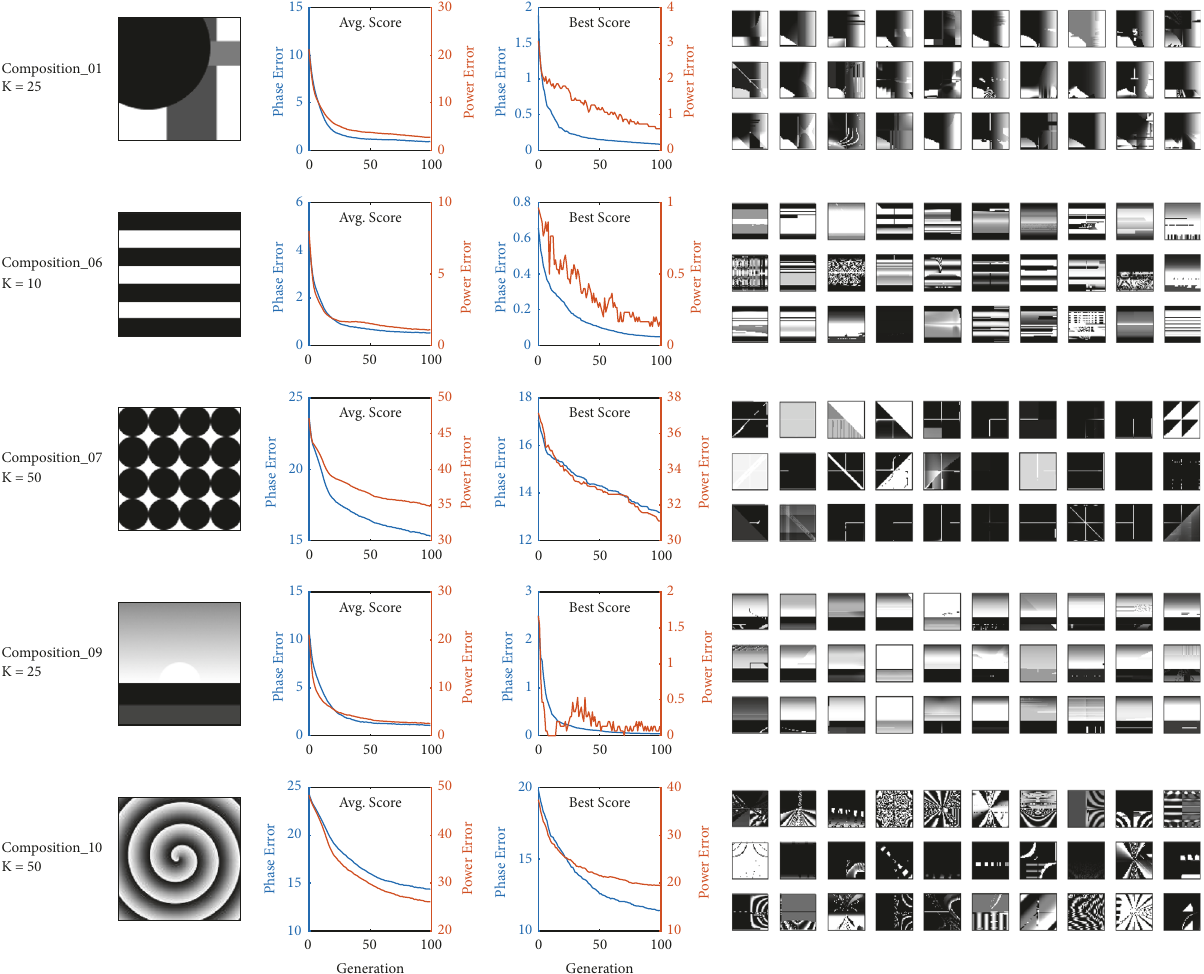
Figure 7: Compositional summary charts and examples. Each row of the figure captures the summary for a target over 30 runs. Leading with the target image, the next two columns show performance plots of the fitness measure (average over 30 runs). The leftmost plot displays the performance through the population average,where the rightmost plot shows the performance of the best individual of the generation. Aside the plots are the best candidate images produced at termination for each run.